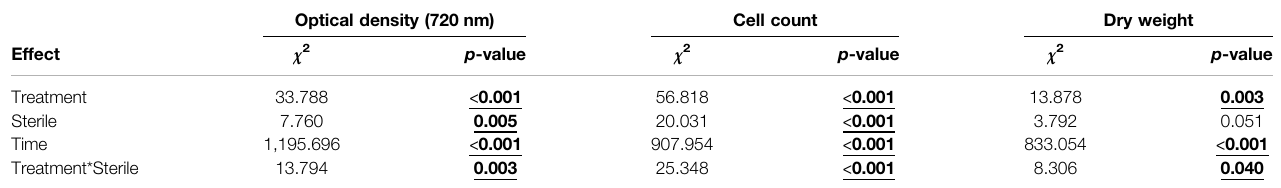
p-values < 0.05 are shown in bold and underlined.